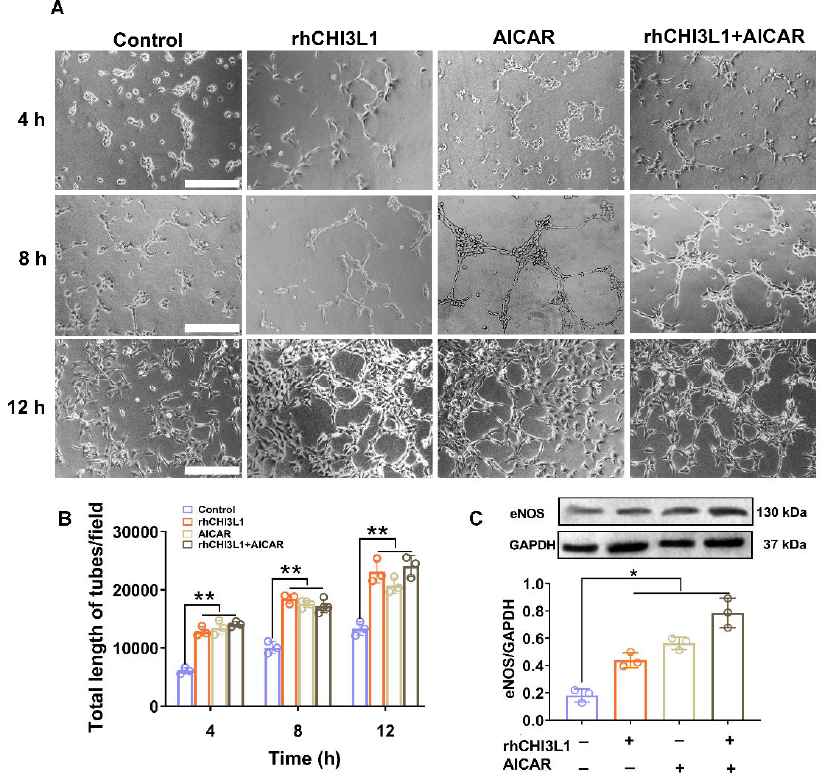
Figure 6. Pro ‐ angiogenesis effects of rhCHI3L1 and AICAR in human umbilical vein endothelial cells (HUVEC). ( A ) Representative microscopic images demonstrating HUVEC tubule formation (scale bar = 500 µ m). ( B ) Bar graph shows quantitative results of HUVEC tubule formation ( n = 3/group). ( C ) Representative pictures of western blotting for detection of expression levels of eNOS, an im- portant pro-angiogenic protein in HUVEC cells under various treatments along with the bar graph showing densitometric results of the eNOS protein band normalized with GAPDH, a housekeeping control protein ( n = 3/group). Abbreviations : rhCHI3L1, recombined human chitinase-3-like protein 1; AICAR, 5-aminoimidazole-4-carboxamide-1- β -D-ribofuranoside; eNOS, endothelial nitric oxide synthase. Symbol * indicates p < 0.05 and ** indicates p < 0.01 between the relevant groups that are